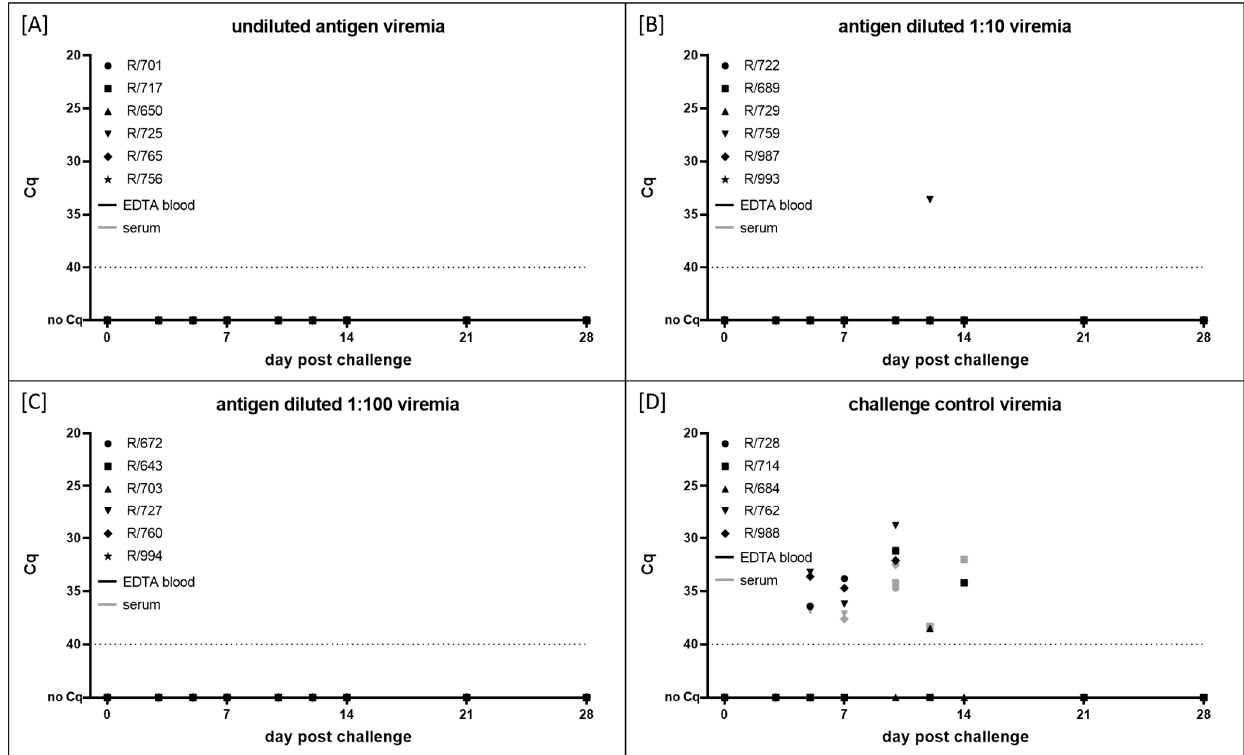
Figure 3. Cell ‐ associated (EDTA blood samples, black marks) and cell ‐ free viremia (serum, gray marks) after challenge infection. Animals were vaccinated with inactivated LSDV vaccine candidate with different amounts of antigen and then challenged with virulent LSDV ‐ Macedonia2016. ( A ) Vaccine virus titer before inactivation was 10 6 CCID 50 /mL on BHK ‐ 21 cell line. ( B , C ) Antigen was diluted 1:10 and 1:100, respectively, before adjuvant was added. ( D ) Cattle in group D were housed